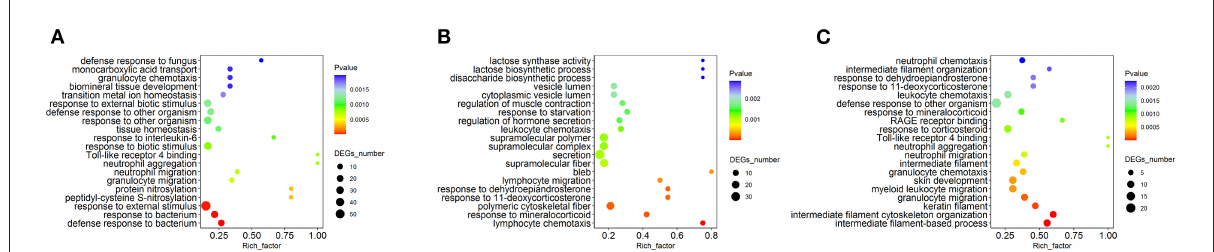
FIGURE4 Gene ontology (GO) enrichment analysis of differentially expressed MFGM proteins. (A) The GO enrichment analysis of differential proteins in MP/LP treatment; (B) The GO enrichment analysis of differential proteins in HP/MP treatment; (C) The GO enrichment analysis of differential proteins in HP/LP treatment.